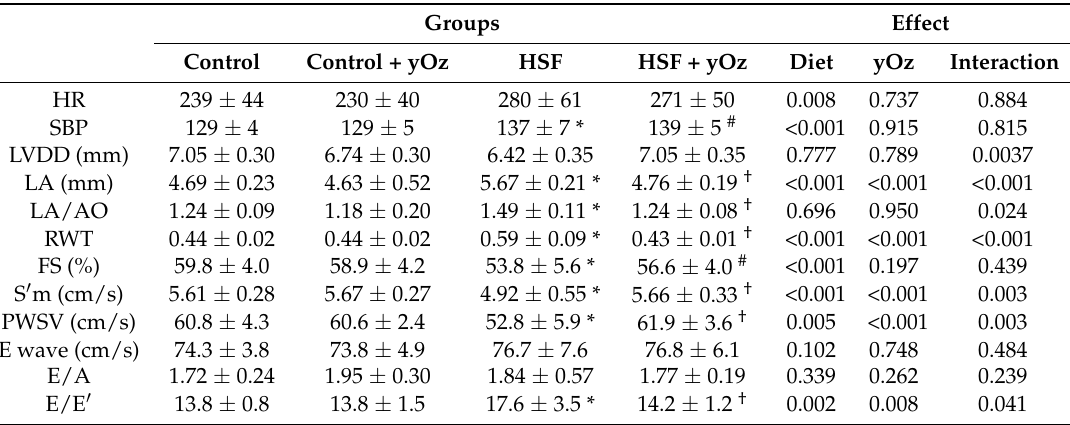
Table 3. Cardiac function and systolic blood